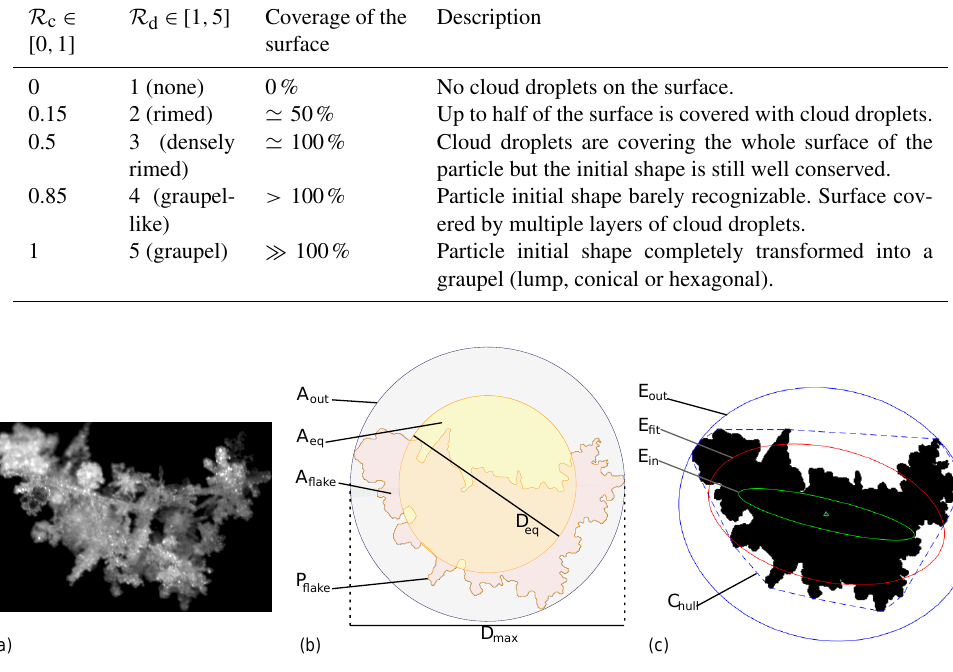
Figure 1. Illustration of various particle geometrical descriptors. (a) Snowflake image obtained with the MASC. (b) Particle projected area A flake , perimeter P flake , maximum dimension D max , equivalent-area diameter D eq and circumscribed circle area A out . (c) Ellipse fit E fit , inscribed ellipse E in , circumscribed ellipse E out and convex hull C hull